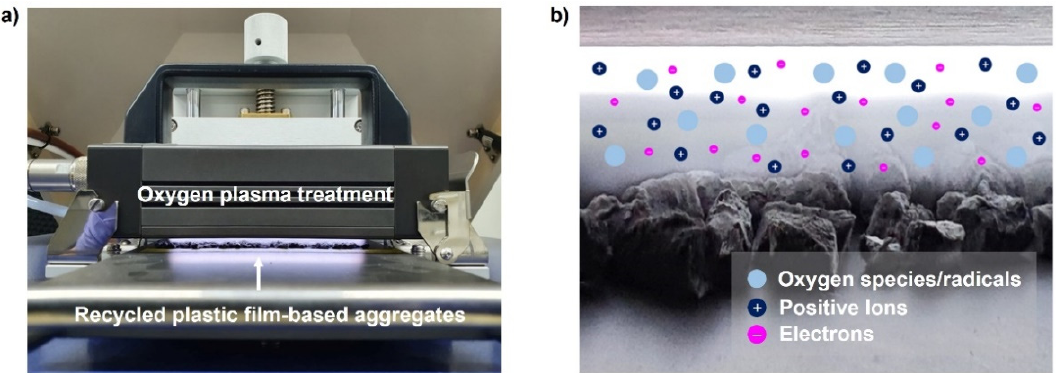
Figure 4. ( a ) Photograph and ( b ) schematics of the oxygen plasma treatment. Reactive oxygen species, radicals, positive ions, and electrons can be created by plasma discharge.